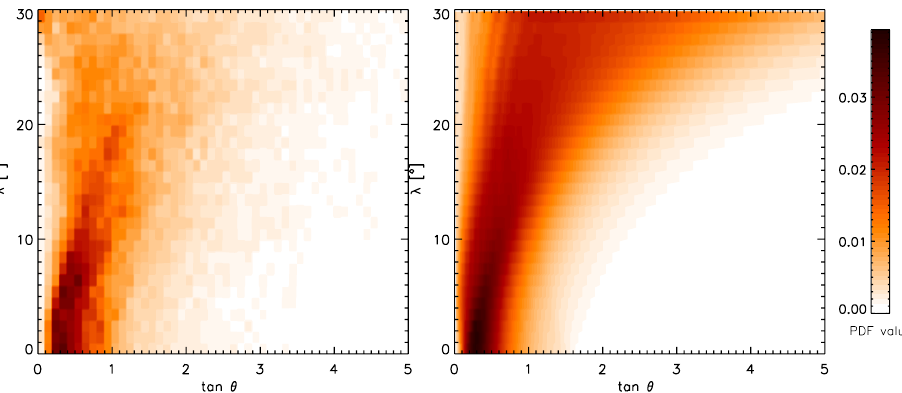
Fig. 4. The PDF of tan θ distribution (x-axis) as a function of magnetic latitude (y-axis) for all computed rays, using Eq. (1) as initial weight function. Distributions are obtained from Cluster experimental data (left panel) and numerical simulations (right